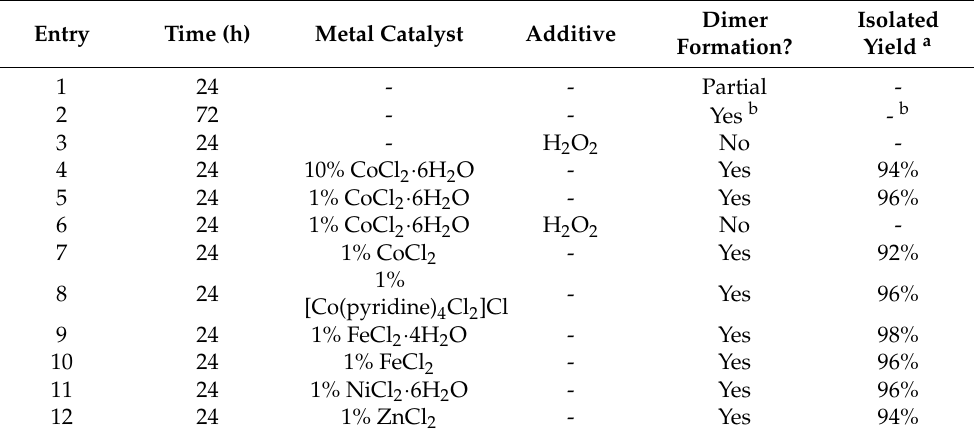
methylene source. All reactions were run at 175 ◦ C in high pressure reaction test tubes.